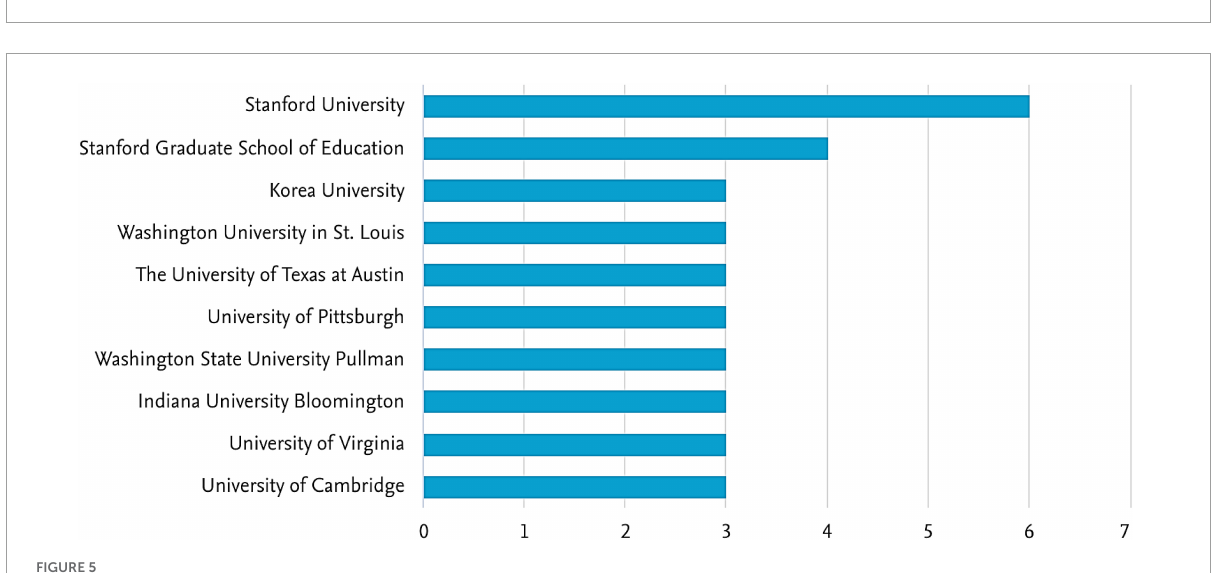
FIGURE4 Multi-country (MCPs) and single-country (SCPs) publications by country.